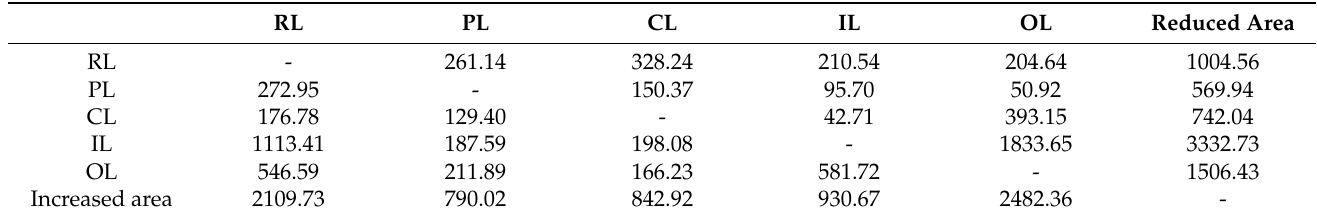
Table 1. Transition matrix of functional urban land replacement from 2003 to 2015. Unit: ha. RL PL CL IL OL Reduced Area Figure 5. Overall characteristics of the kernel density of functional urban land conversion. This fig- ure is the kernel density map of the total conversion area of the four types of functional urban land, including the area of “convert in” and “convert out”, so the kernel density value is greater than that of a certain type of functional urban land.